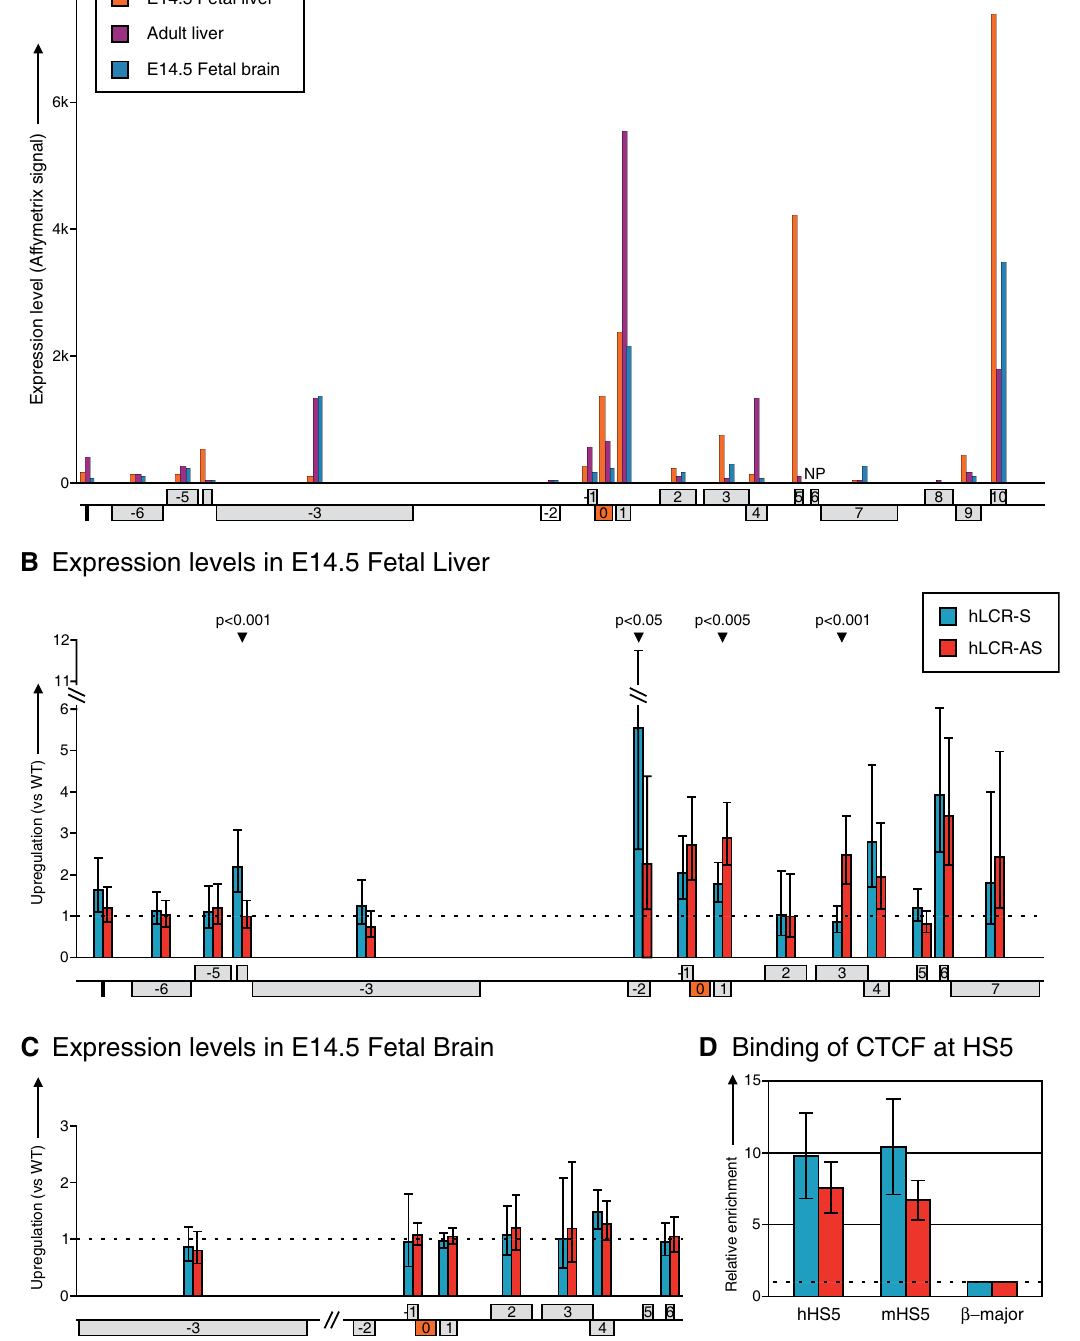
Figure 2. Gene expression in different tissues at 8C3/C4. (A) Expression levels in fetal liver, fetal brain and adult liver of genes at 8C3/C4 represented on murine Affymetrix 430 2.0 Micro-array. NP: not present on the micro-array. (B) Upregulation of gene expression relative to WT levels (for each gene set at 1) in strains with the human b -globin LCR integrated at the Rad23a locus (orange). Expression levels were determined in E14.5 fetal liver using qRT-PCR. Error bars depict 95% confidence intervals obtained from a Student’s t-test using the Welch-Satterthwaite approximation for the degrees of freedom. P-values of significant differences in expression levels measured between the two oppositely LCRs are shown above the relevant genes. (C) Upregulation of gene expression relative to WT levels (for each gene set at 1) in E14.5 fetal brain containing the human b -globin LCR. Expression levels were determined using qRT-PCR. Error bars depict 95% confidence intervals. (D) Binding of CTCF at HS5 of the human b -globin LCR (hHS5), as determined by ChIP-analysis in E14.5 fetal liver. Enrichments were normalized to the endogenous b -major promoter. Endogenous b - globin HS5 (mHS5) is shown as a control. Error bars represent SE of at least two independent experiments.